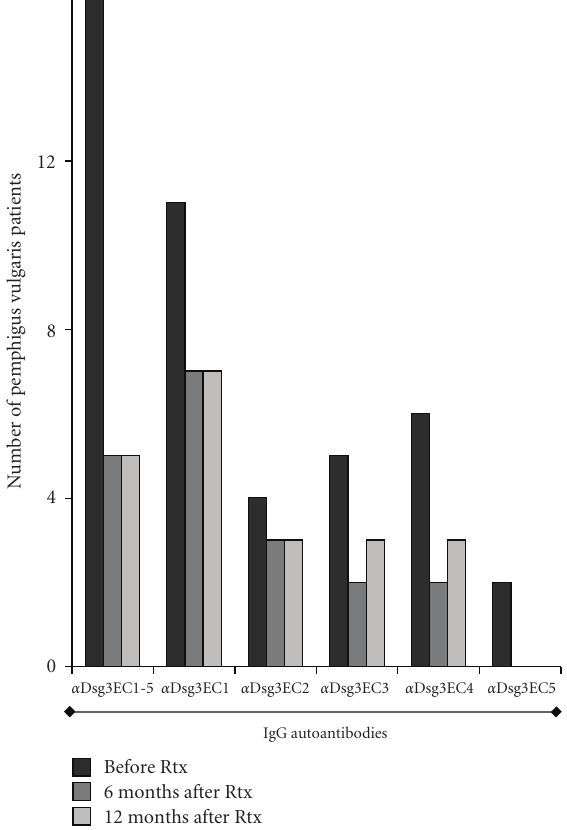
Figure 2: IgG reactivity against desmoglein 3 (Dsg3) subdomains in pemphigus vulgaris (PV) patients on rituximab (Rtx). Illustrated is the number of PV patients showing IgG against Dsg3 subdomains before and 6 and 12 months after treatment with Rtx,